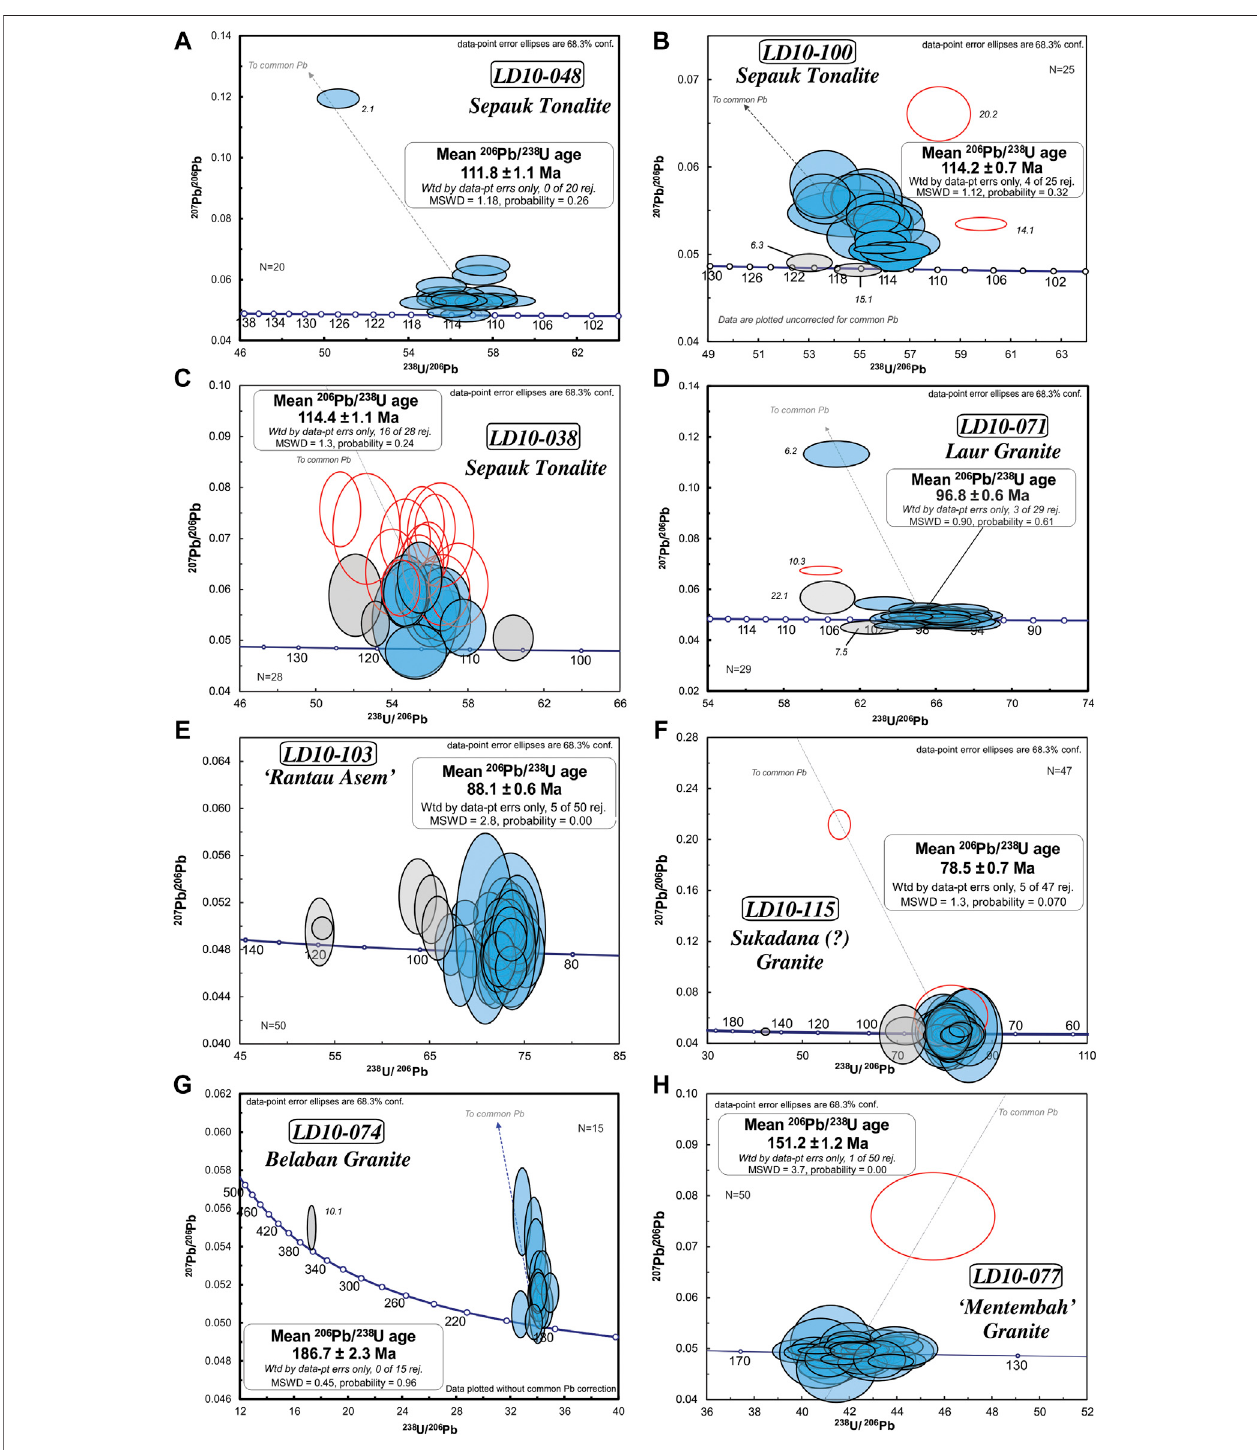
FIGURE 5 | Zircon U-Pb weighted mean age calculation and Tera-Wasserburg diagrams for plutons in the NSZ, the eastern part of the Schwaner Mountains (potentially SSZ), and the Jurassic basement of the SSZ. (A) LD10-048 Sepauk Tonalite NSZ, (B) LD10-071 Laur Granite NSZ, (C) LD10-100 Sepauk Tonalite NSZ, (D) LD10-038 Sepauk Tonalite NSZ, (E) LD10-103 Rantau Asem Tonalite NSZ-SSZ?, (F) LD10-115 Sukadana Granite SSZ?, (G) LD10-074 Belaban Granite SSZ, (H) LD10-077 Mentembah Granite SSZ. SHRIMP diagrams display ages uncorrected for common Pb and for LA-ICP-MS results common Pb corrected ages are displayed. Common Pb correction after Andersen